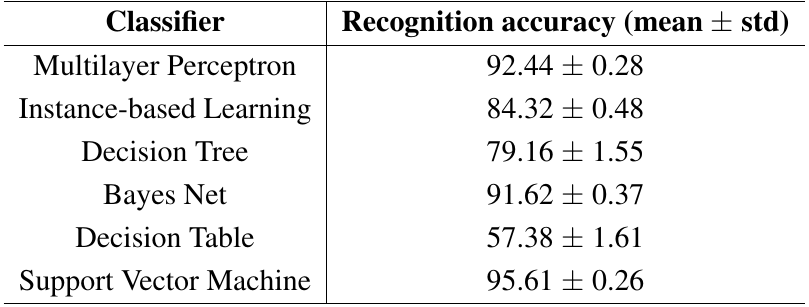
Summary of classifier results (mean ± standard deviation). Comparison of recognition accuracy (%) of user identification by stepping pattern.